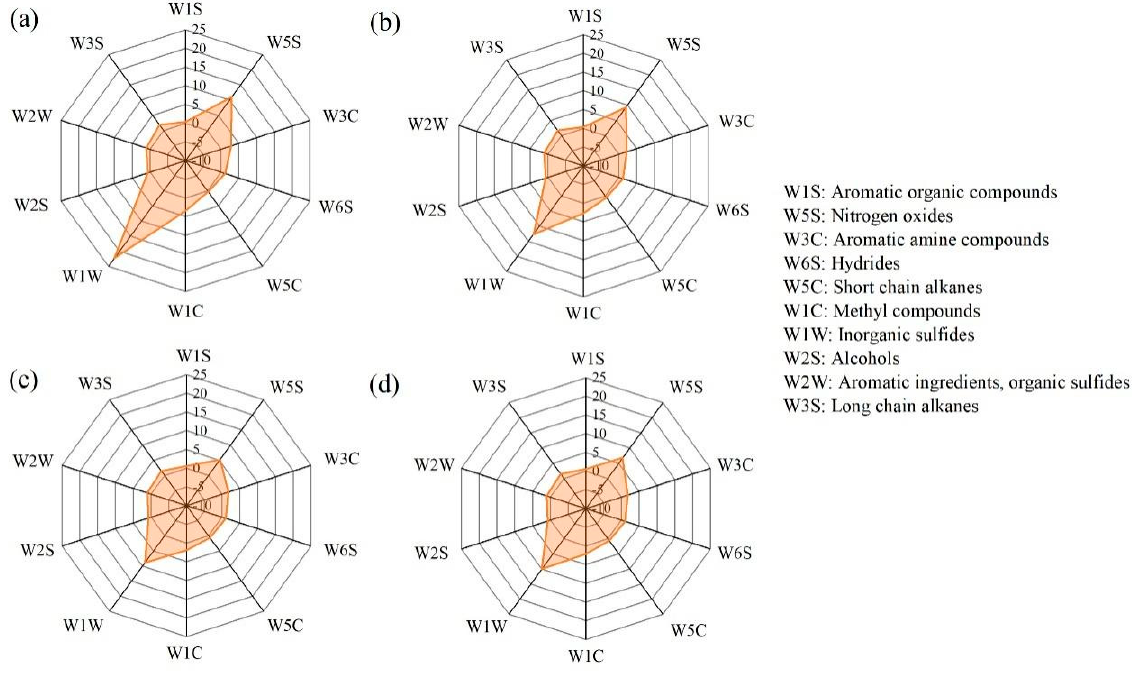
Figure 2. Distribution of volatile compound species in shrimp paste samples during 1 ( a ), 2 ( b ), 3 ( c ), and 8 ( d ) years of fermentation, using an E-nose sensor.